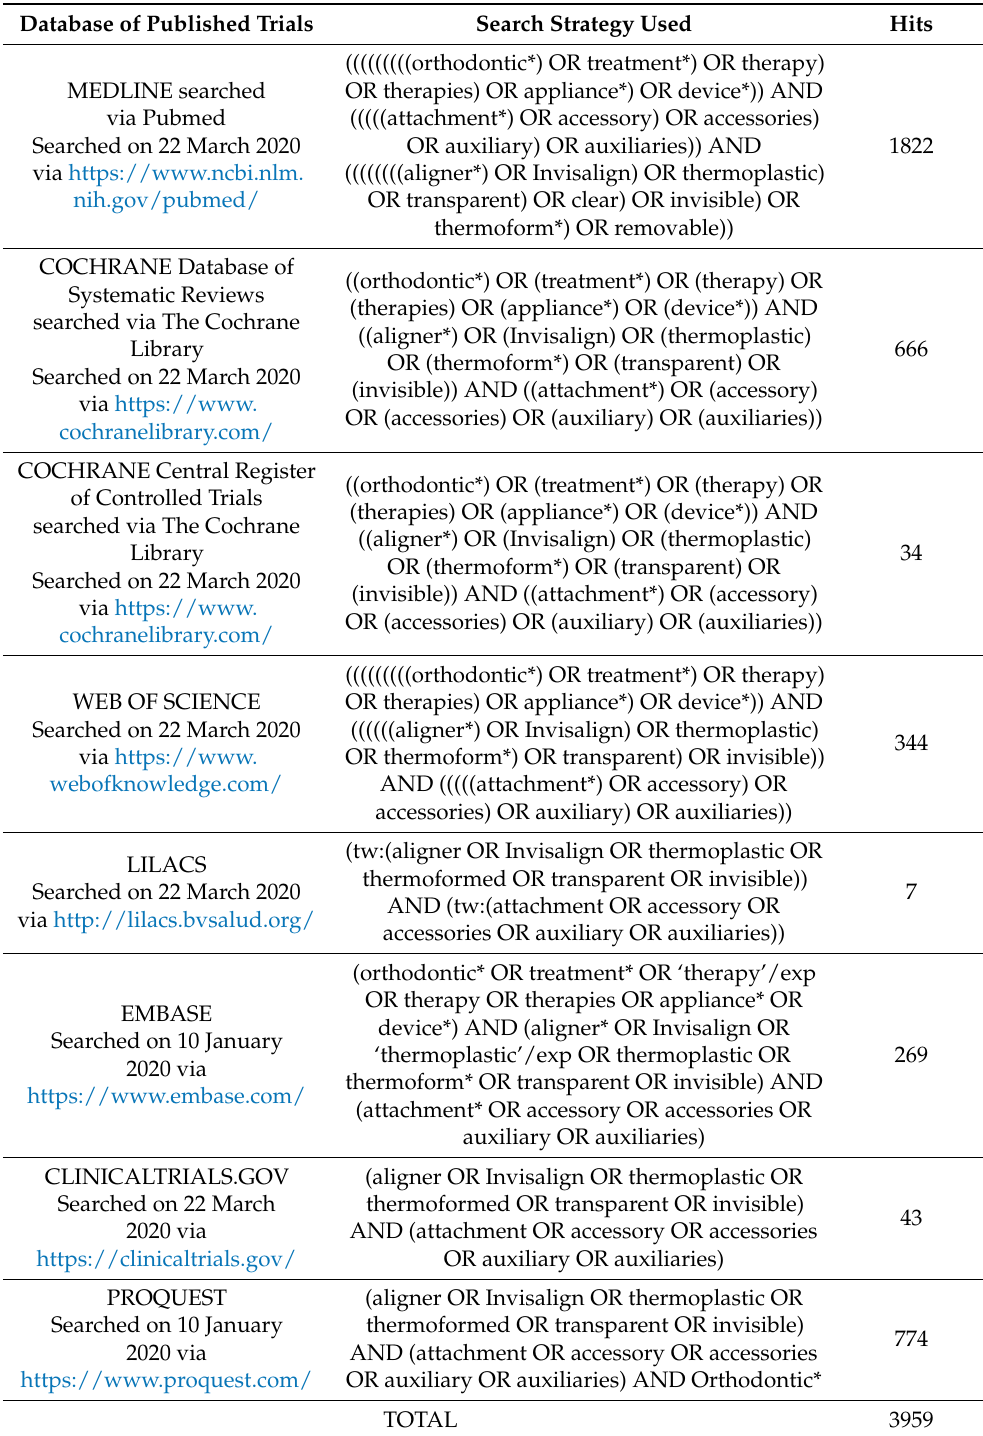
Table 1. Consulted databases, applied search strategy, and numbers of retrieved